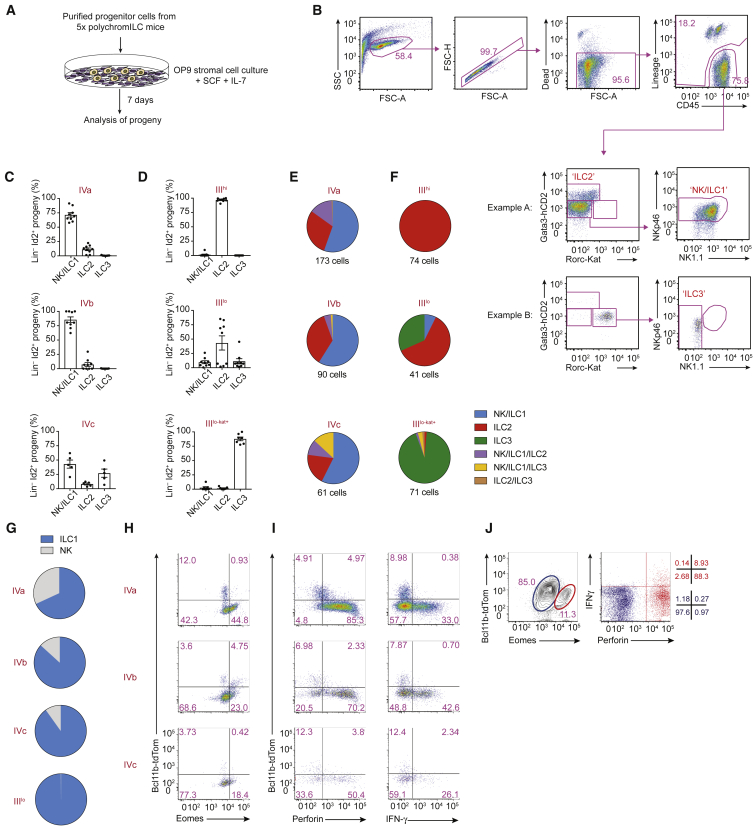
In Vitro Analysis Identifies Multipotent and ILC3-Restricted ILC Progenitors(A) Schematic of purified bone marrow progenitor populations co-cultured in vitro with OP9 stromal cells to facilitate ILC development.(B) Representative flow-cytometry gating strategy for ILC subsets generated in vitro after co-culture of progenitor cell populations, purified from the bone marrow of the 5x polychromILC mice, with OP9 stromal cells.(C) Flow-cytometry analysis of the proportions of ILC subsets generated in vitro after co-culture of progenitor cell populations IVa, IVb, and IVc, purified from the bone marrow of 5x polychromILC mice, with OP9 stromal cells.(D) Flow-cytometry analysis of the proportions of ILC subsets generated in vitro after co-culture of progenitor cell populations IIIhi, IIIlo, and IIIlo-kat+, purified from the bone marrow of 5x polychromILC mice, with OP9 stromal cells.(E) Characterization of progeny derived from clonal analysis of single IVa, IVb, and IVc progenitor cells, purified from the bone marrow of 5x polychromILC mice, after co-culture with OP9 stromal cells.(F) Characterization of progeny derived from single IIIhi, IIIlo, and IIIlo-kat+ progenitor cells, purified from the bone marrow of 5x polychromILC mice, after co-culture with OP9 stromal cells.(G) Proportion of Eomes+ (NK) and Eomes− (ILC1) cells after co-culture of the indicated progenitor populations, purified from the bone marrow of 5x polychromILC mice, with OP9 stromal cells.(H) Flow-cytometric analysis of cells derived from IVa, IVb, and IVc progenitor populations for the expression of Eomes (co-cultured with OP9 stromal cells).(I) Flow-cytometric analysis of cells derived from IVa, IVb, and IVc progenitor populations for the expression of perforin and IFN-γ (co-cultured with OP9 cells and stimulated for 48 hr with IL-2, IL-15, and IL-18).(J) Flow-cytometric analysis of Bcl11b, Eomes, perforin, and IFN-γ expression in LiveCD45.2+ spleen cells stimulated in vitro with IL-2, IL-15, and IL-18, 6 weeks after transfer of IVa cells into Rag2−/−Il2rgc−/− recipients.(A–D) Data are pooled from 3 independent experiments; mean ± SEM of 5–9 replicate cultures. (E and F) Data are pooled from 3 independent experiments. (G) Data are pooled from 2 independent experiments. (H and I) Data are representative of 3 independent experiments. (J) shows data concatenated from 7 animals taken from 2 independent experiments. Please also see Figure S6.